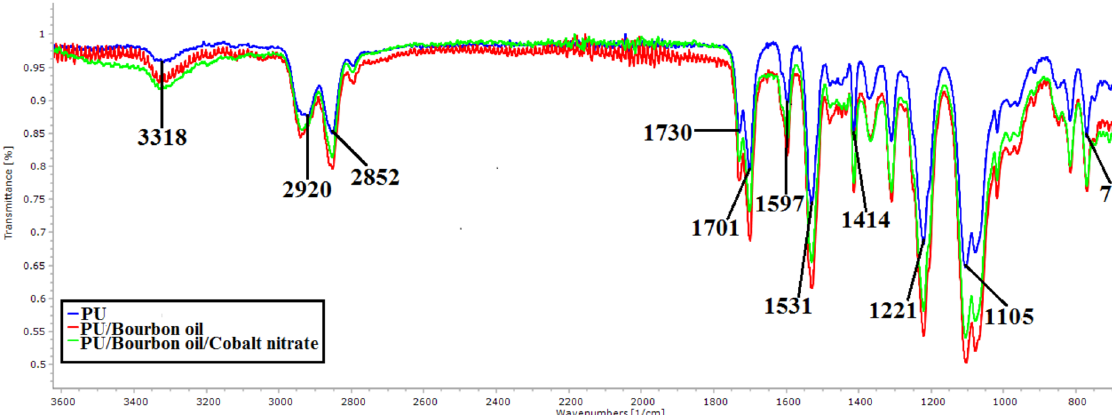
Figure 3. TGA curve of a) PU, PU/BB and PU/BB/ CONO 3